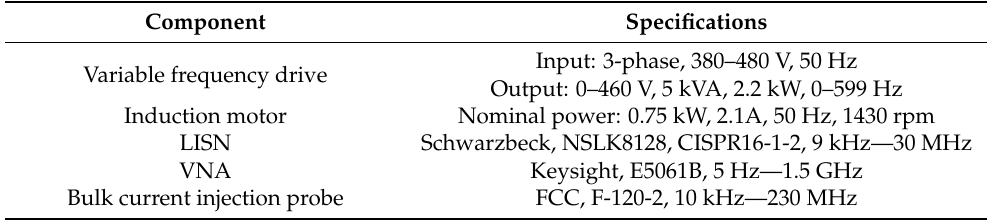
Table 3. Specifications of motor drive system and instruments.